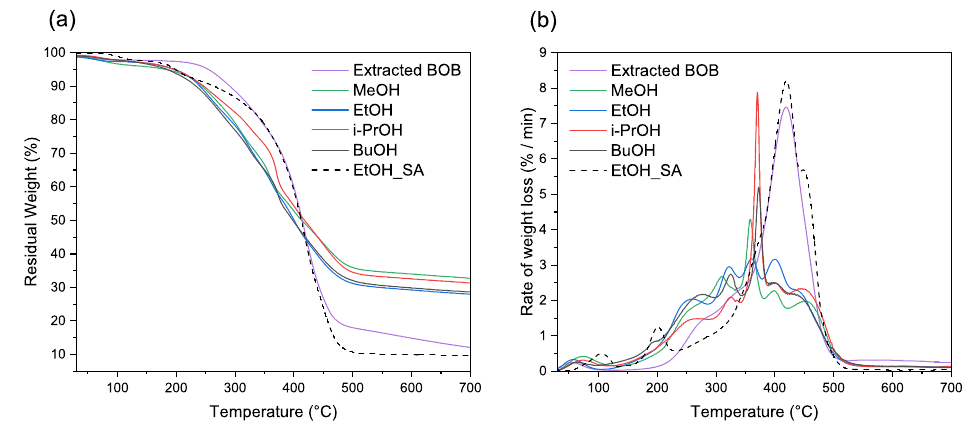
Figure 3. TGA ( a ) and DTGA ( b ) curves for adhesive and feedstock samples.